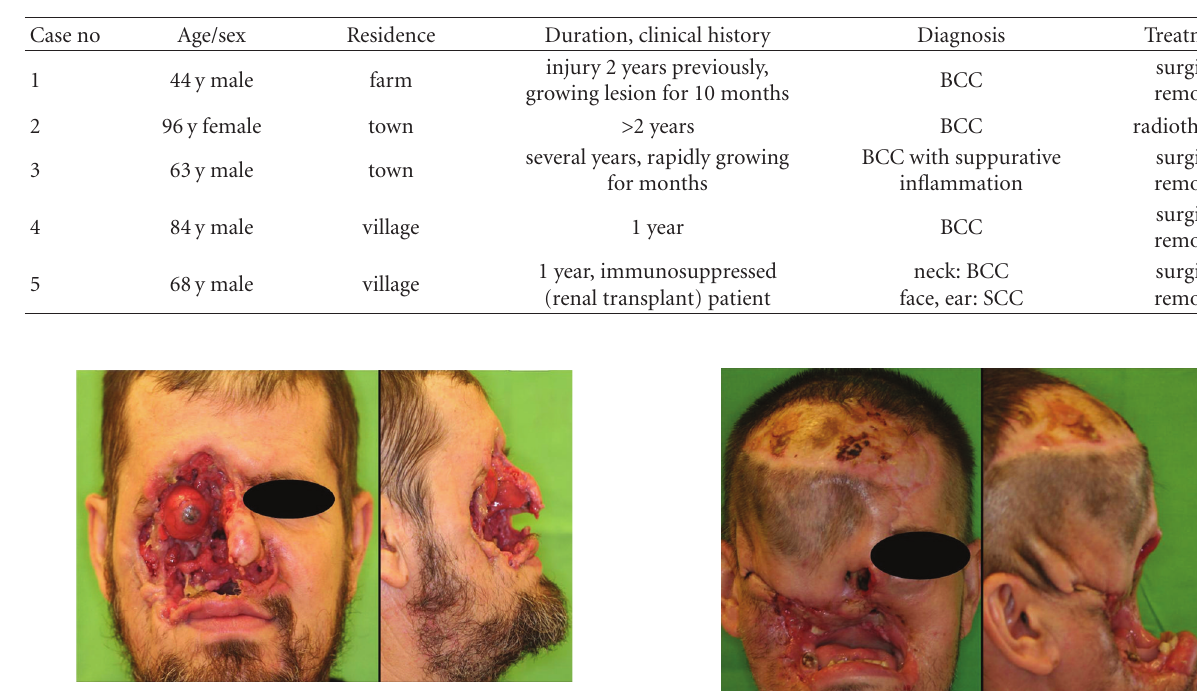
Table 1: Data on the neglected BCC patients and their treatment (BCC: basal cell carcinoma, SCC: squamous cell carcinoma).